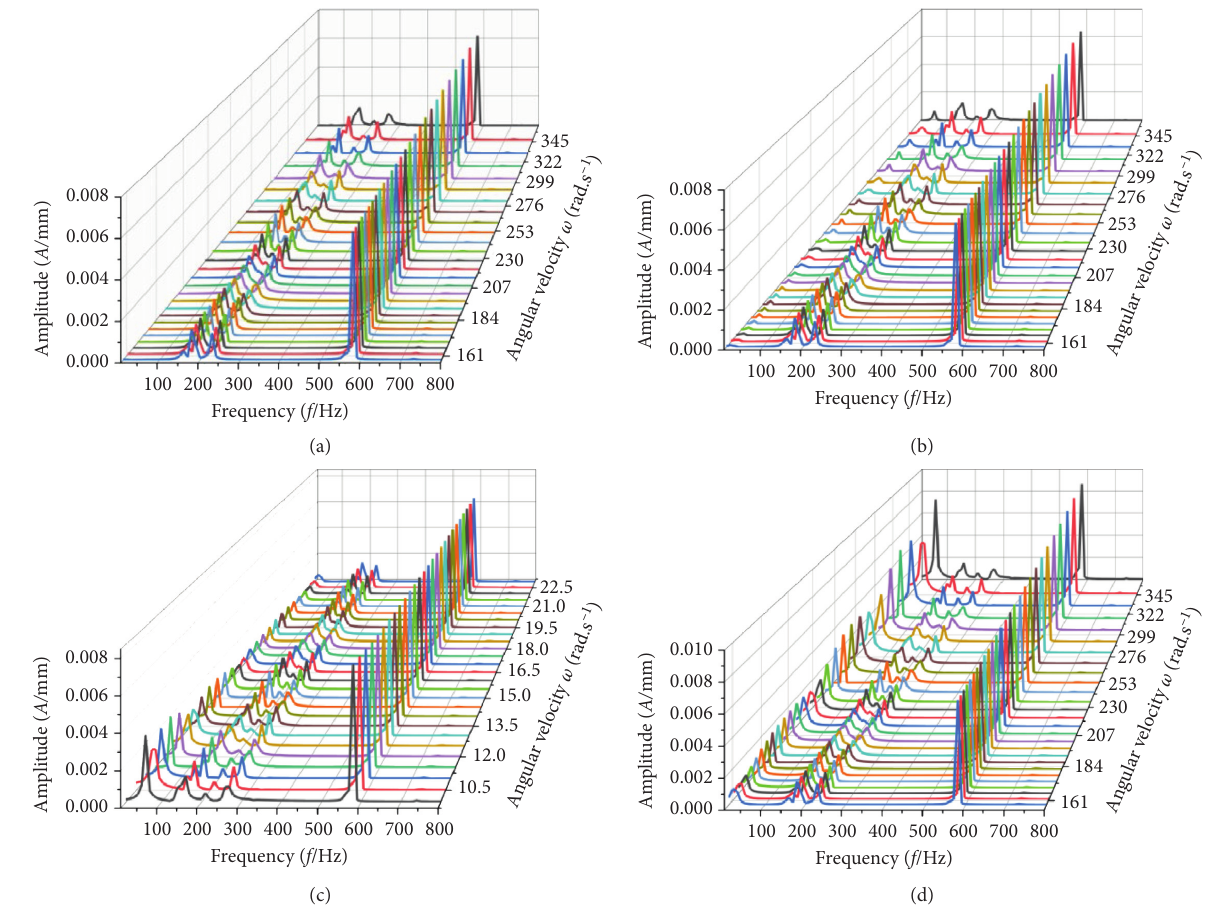
Figure 5: Spectrum diagram under different eccentricity. (a) e � 0.01 mm. (b) e � 0.10mm. (c) e � 0.50mm. (d) e �